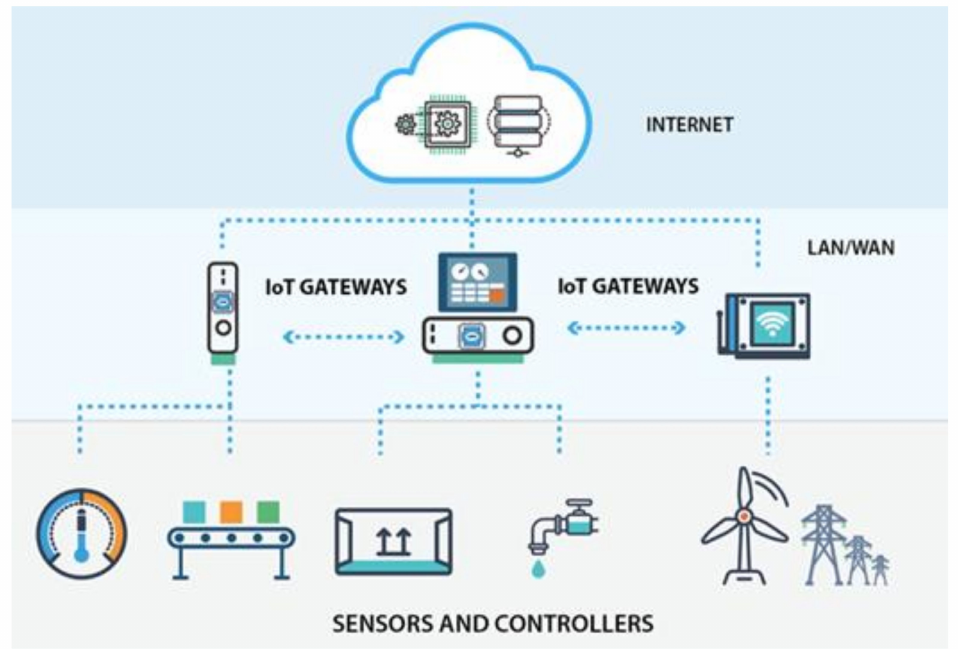
Figure 14. IoT support to the microgrid.